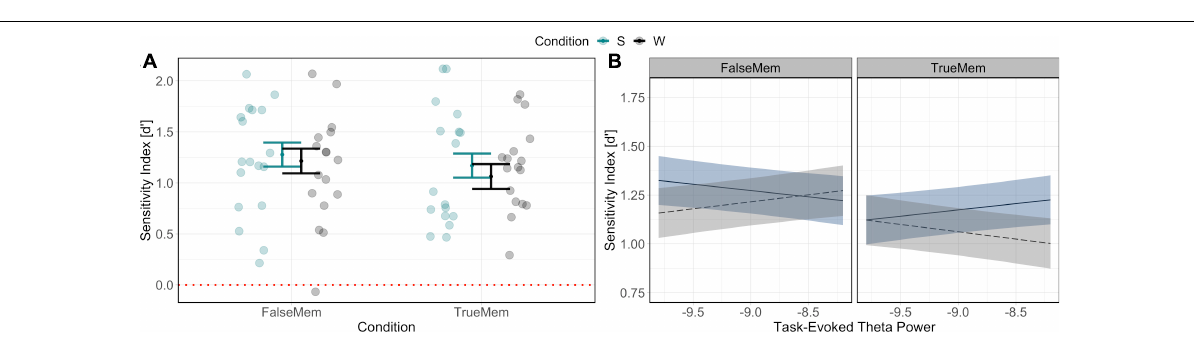
FIGURE 4 | Behavioural (A) and power spectral (B) results in determining memory for list words and associative lures. In panel (A) behavioural results indicate a slight increase in accuracy in the recognition of associative lures across sleep and wake retention intervals. In panel (B) results indicate a complex relationship between theta power at encoding, memory type, and sleep/wake. Dashed line in (A) indicates chance